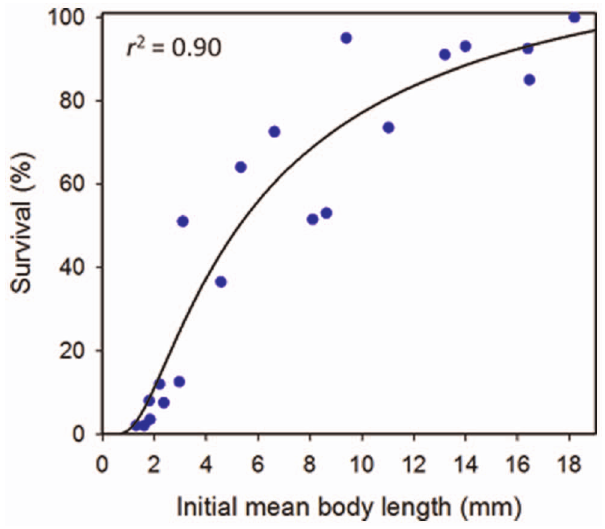
Figure 6. Effects of sediment type and sediment depth. Scatterplot of survival of juvenile sandfish in fine-mesh enclosures across various initial mean group body lengths, three weeks after transfer from hatchery tanks; n =20 fine-mesh enclosures. The fitted curve is the most appropriate nonlinear function by AIC selection.